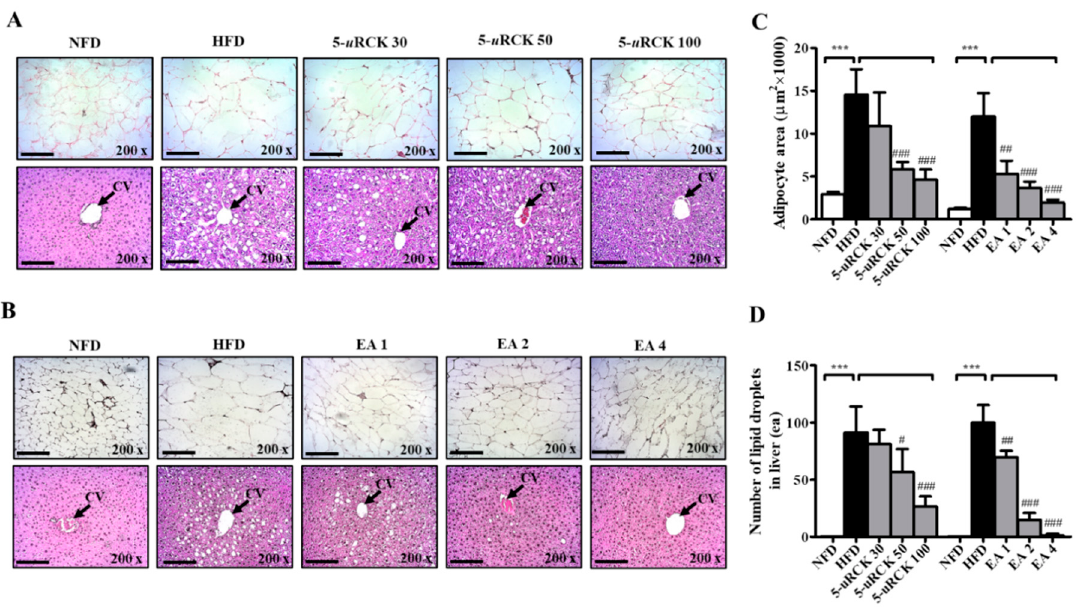
Figure 6. E ff ects of 5- u RCK and ellagic acid on histological changes and lipid accumulation in eWAT and liver tissues of HFD-induced obese mice. Histological changes were determined via hematoxylin and eosin (H&E) staining in epididymal white adipose tissue (eWAT) and liver tissue sections (magnification, × 200) of mice from the ( A ) 5- u RCK and ( B ) ellagic acid post-treated mice. The arrow indicates the central vein (CV). ( C ) The adipocyte size was quantified microscopically from representative sections (n = 18). ( D ) The number of lipid deposits in H&E-stained livers was calculated in at least five images in each group. *** p < 0.001 vs. NFD group; # p < 0.05, ## p < 0.01 and ### p < 0.001 vs. HFD group. Scale bars = 200 µ